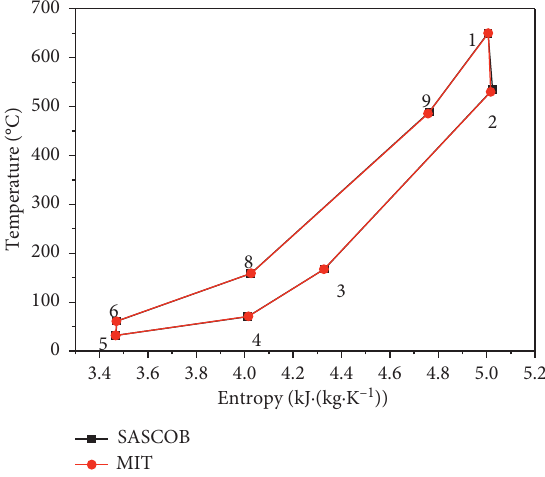
Figure 7: Temperature-entropy comparison between calculated and MIT design